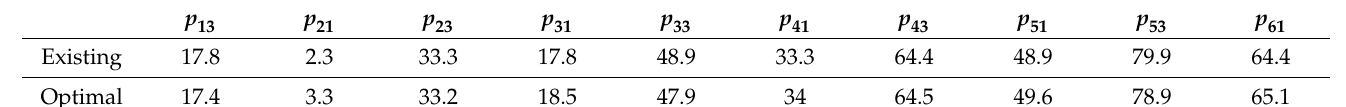
Table 8. Updated value after context optimization of the optimized CGK-based fuzzy granular model of the aggregated structure.